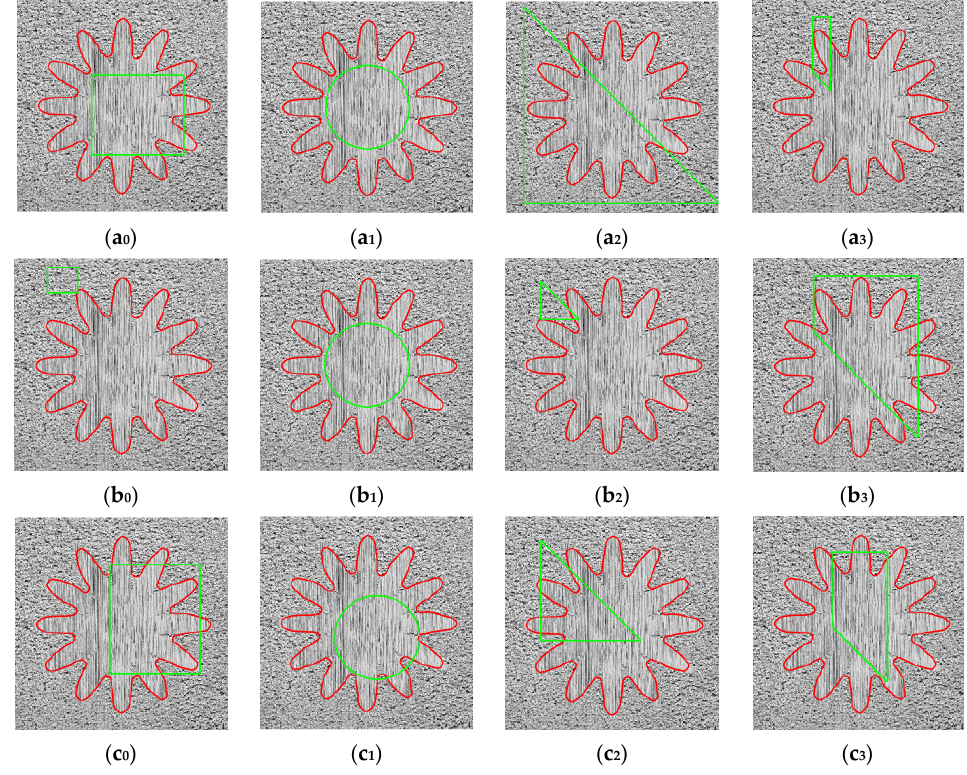
Figure 4. Segmentation results of different initial contours: ( a 0 , b 0 , c 0 ) denote the results of the segmentation of different rectangular initial contours; ( a 1 , b 1 , c 1 ) denote the results of the segmentation of different circular initial contours; ( a 2 , b 2 , c 2 ) denote the results of the segmentation of different triangular initial contours; ( a 3 , b 3 , c 3 ) denote the results of the segmentation of different trapezoidal initial contours